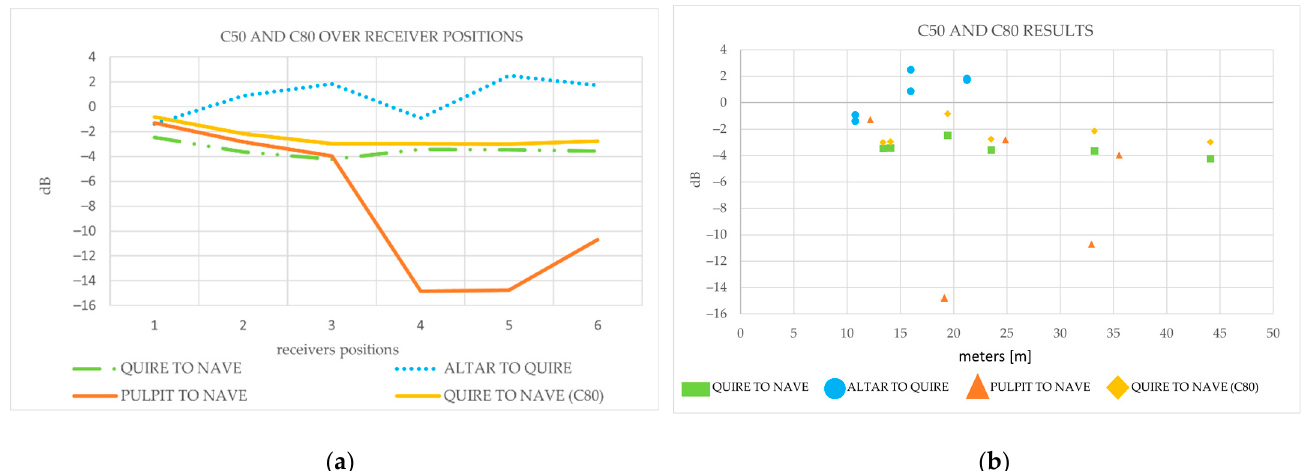
Figure 10. C50 and C80 results over standard frequency bands.